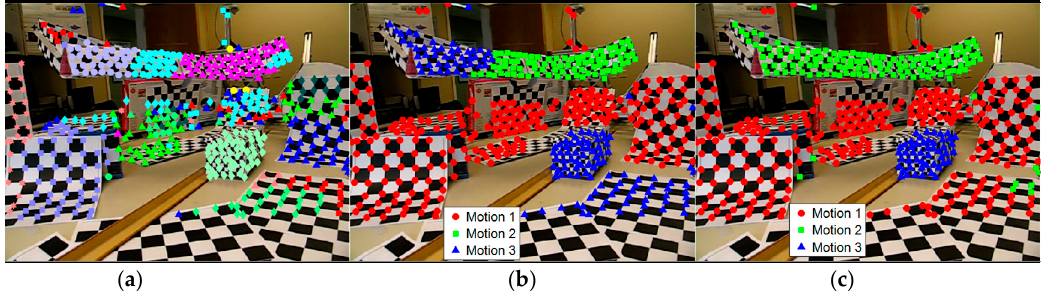
Figure 2. Model selection results obtained on checkerboard sequence 2RT3RCT_B. ( a ) Data grouping results obtained by Equation (7), which is the initial input of the model selection; ( b ) intermediate results of model selection during iterations; ( c ) final segmentation results obtained after model selection .